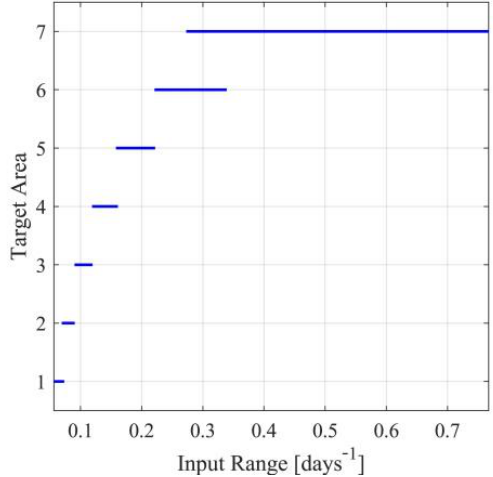
Figure 6. Target operating areas.